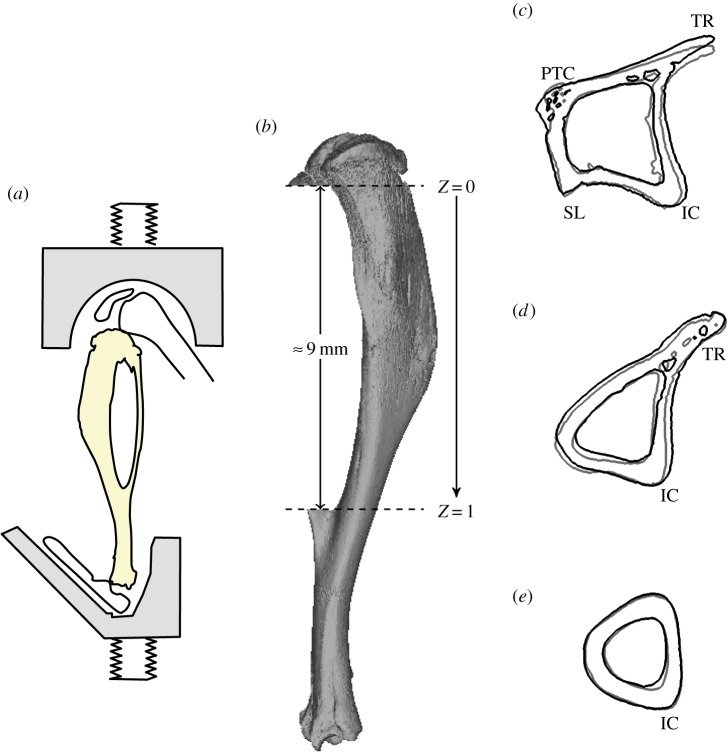
(a) The loading model used for this study: axial compression of the murine tibia (adapted from [23]). (b) Non-dimensional coordinate, Z, corresponds to the axial space between the proximal (Z = 0) and distal (Z = 1) tibia–fibula junctions. (c–e) Cross-sectional contours of left (non-loaded, grey line) and right (loaded, black line) tibiae for a particular specimen. Anatomical landmarks: interosseous crest (IC), proximal tibial crest (PTC), soleal line (SL), tibial ridge (TR). (c) Z = 0.2, (d) Z = 0.5 and (e) Z = 0.8.